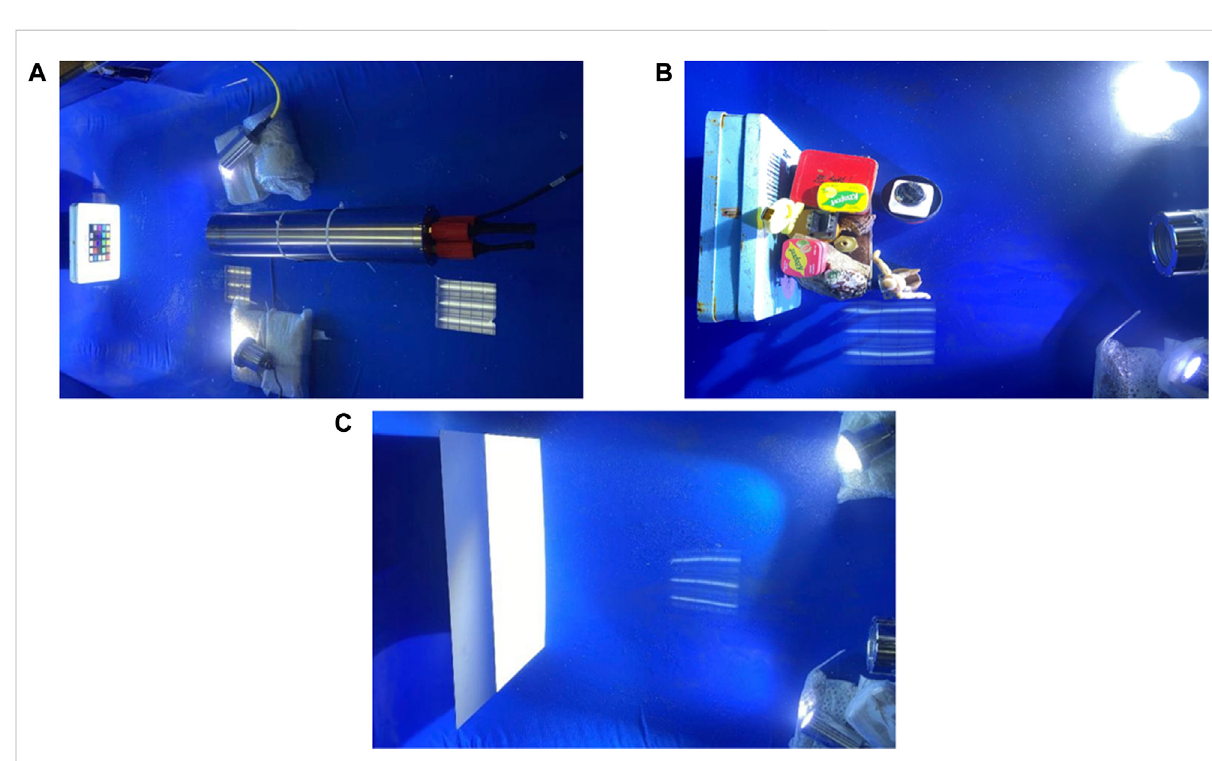
FIGURE 9 Underwater spectral imaging performance test. (A) Underwater hyperspectral imager scanning the color blocks. (B) Underwater hyperspectral imager scanning different objects. (C) Underwater hyperspectral imager scanning the standard whiteboard.